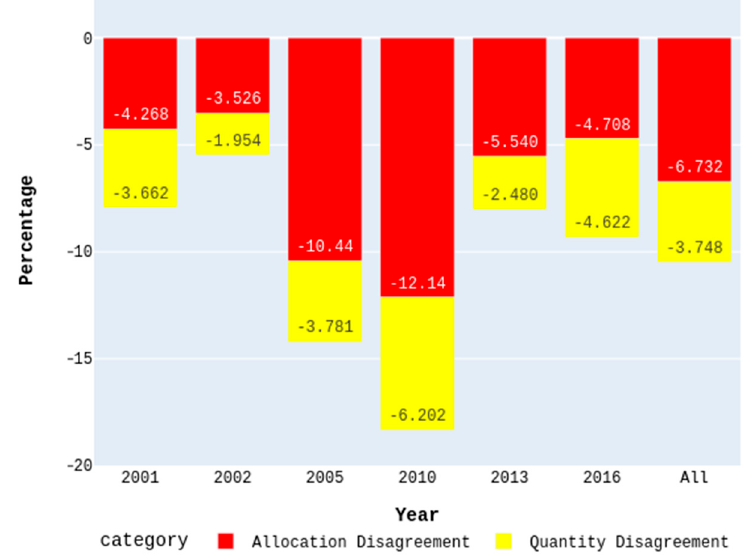
Figure 13. Plot of error metrics of series fire maps.